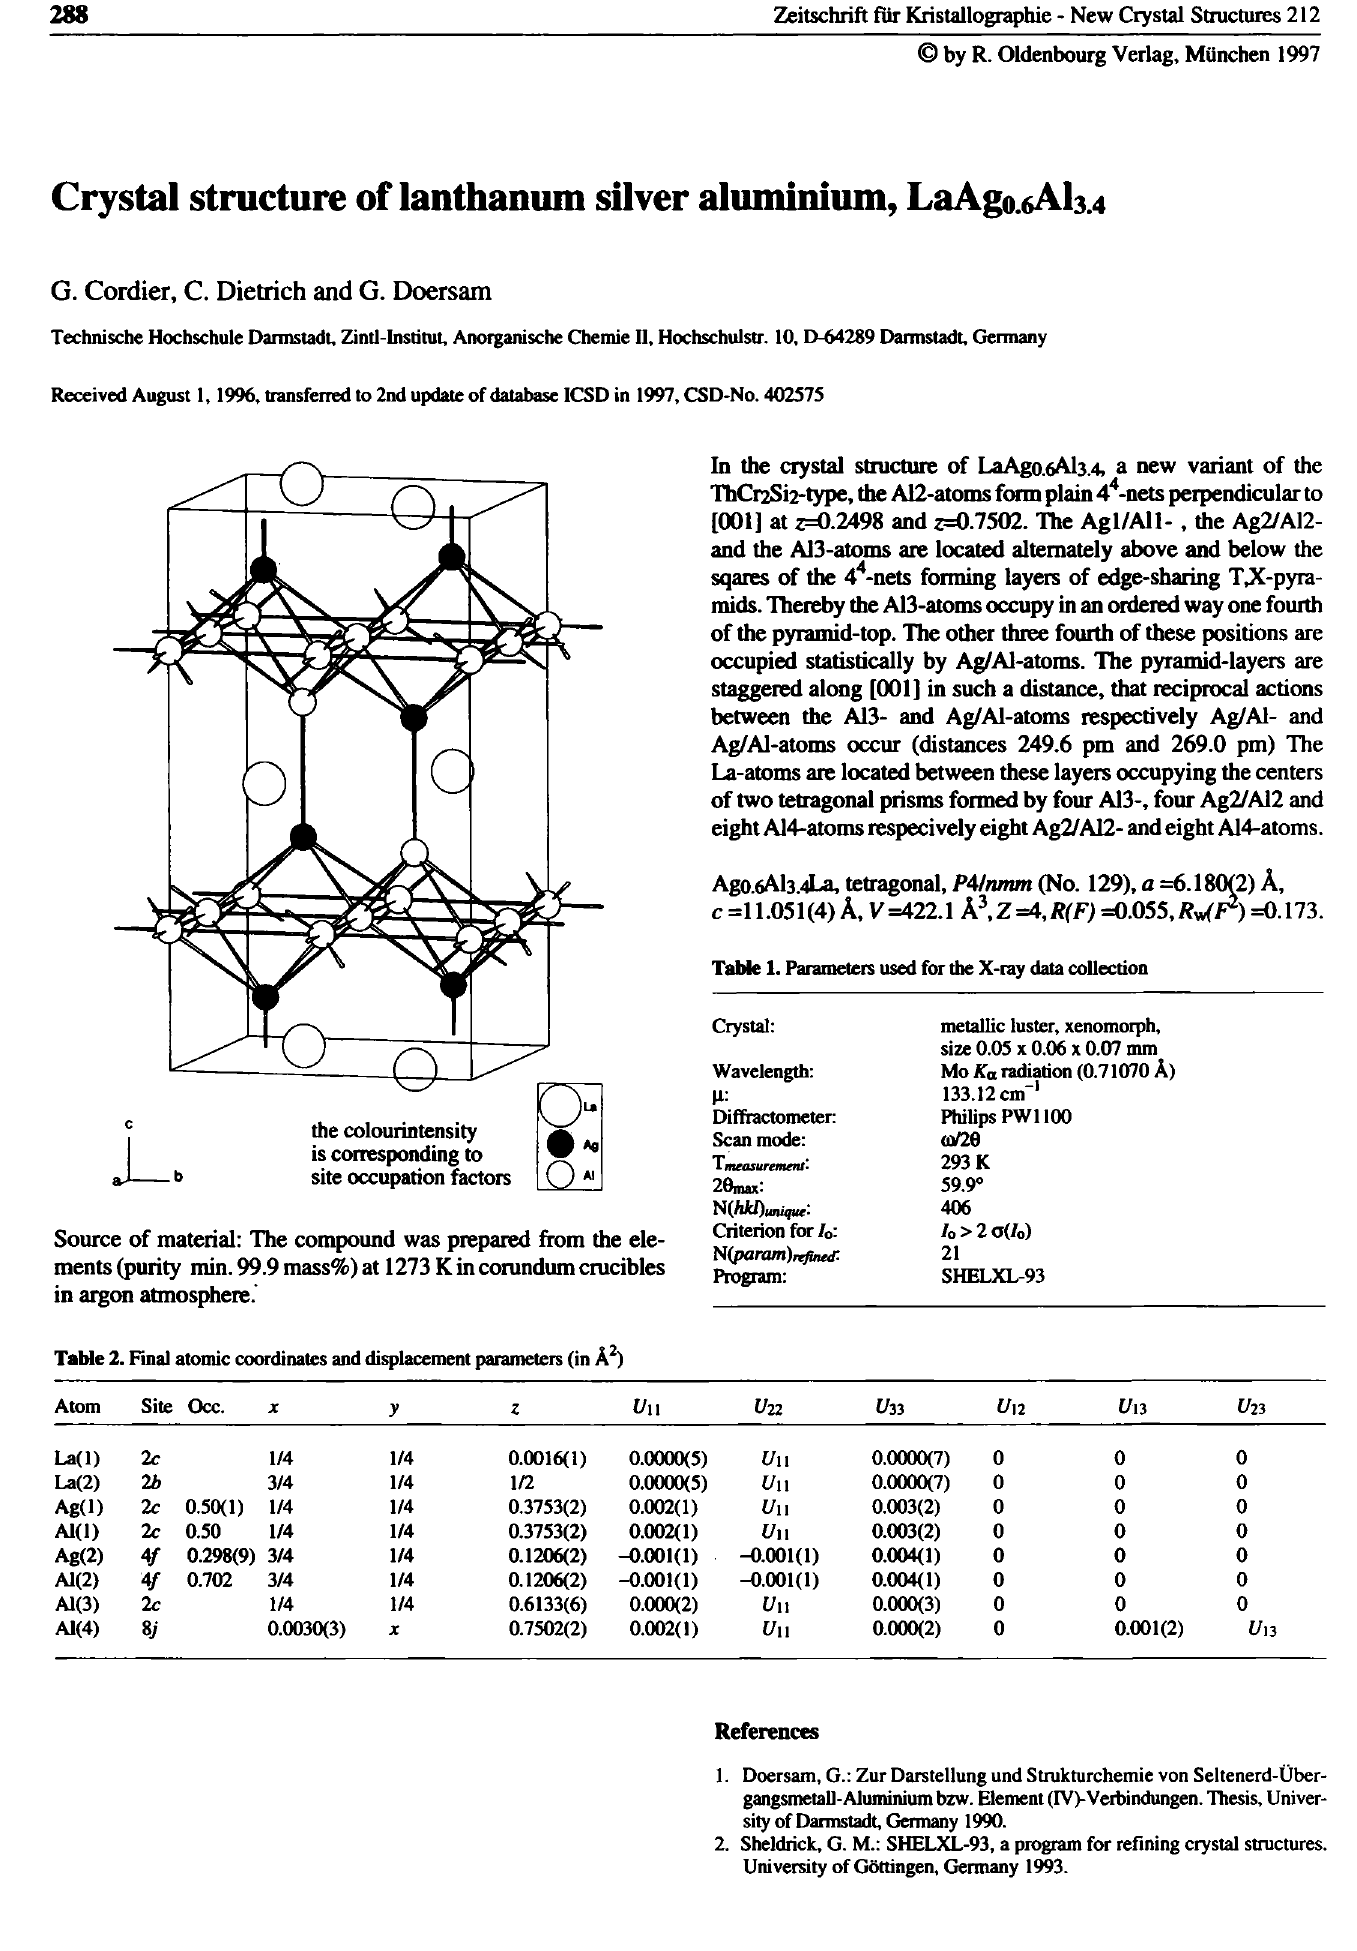
Table 2. Final atomic coordinates and displacement parameters (in Â 2 ) Atom Site